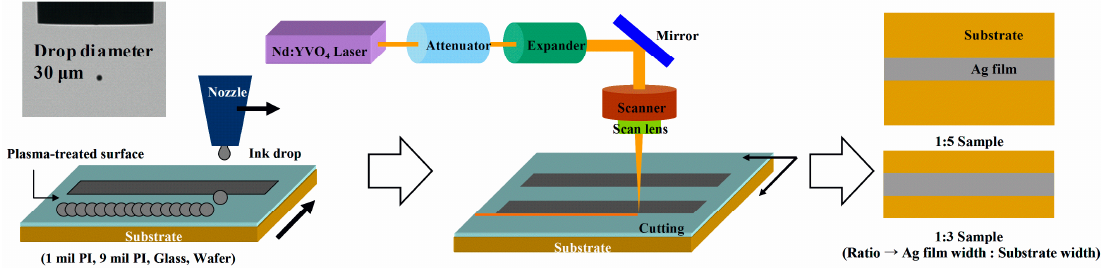
Figure 1. Schematic of the printing procedure to fabricate the test specimen using a MicroFab piezoelectric print head and Nd:YVO4 laser pulse cutting.